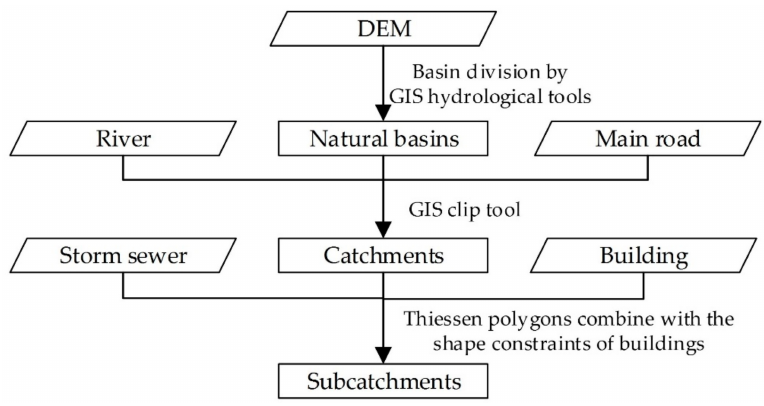
Figure 1. Catchment discretization based on geographic information system (GIS)